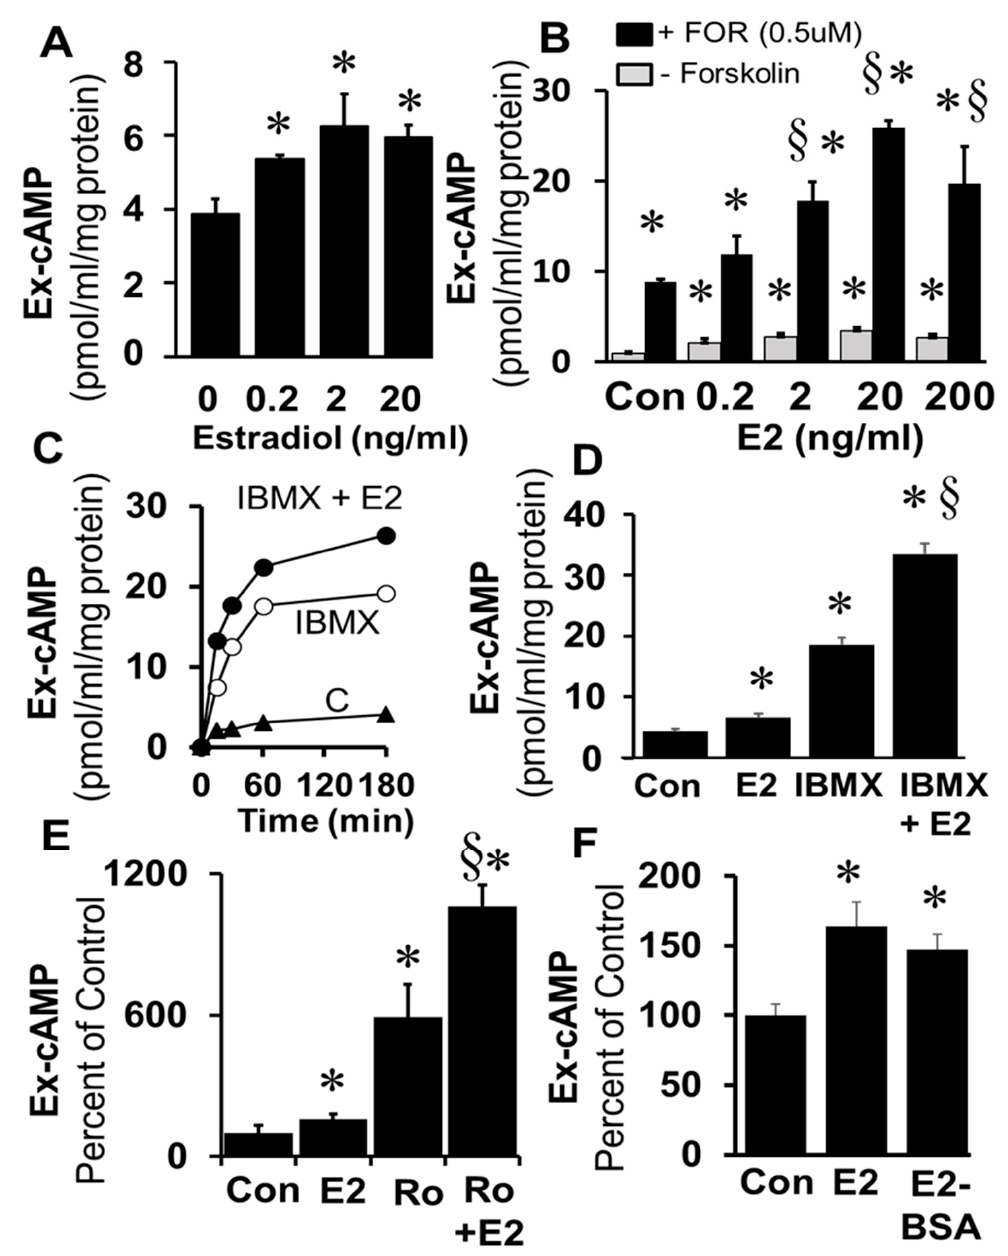
Figure 3. Panel ( A ) shows the concentration-dependent effects of 17 β -estradiol (E2; 0.2, 2, 20 ng/mL) on extracellular (Ex) cAMP levels in freshly prepared FT cells treated for 15 min. Panel ( B ) depicts the stimulatory effects of E2 (0.2, 2, 20, 200 ng/mL) in confluent monolayers of FT cells in the presence of the adenylyl cyclase stimulator forskolin (0.5 µ M). Panel ( C ) shows the time-dependent increases in cAMP levels in FT cells treated for 0–180 min with IBMX (1 µ M) or IBMX (1 µ M) plus E2 (20 ng/mL) compared with untreated control ( C ) cells. Panel ( D ) depicts the stimulatory effects of E2 (20 ng/mL) on cAMP levels in FT cells in presence of IBMX (1 µ M) after 180 min. Panel ( E ) shows the stimulatory effects of E2 (20 ng/mL) on cAMP levels in FT cells in presence of Ro20-1724 (1 µ M) after 180 min. Panel ( F ) shows the stimulatory effects of E2 and its membrane impermeable analog (E2-BSA) on cAMP levels in cultured FT cells treated for 15 min. Data (mean ± SEM) represent the mean of three different experiments ( n = 3) in triplicate. Values were normalized to total protein concentration and the cAMP level is expressed as pmol/mL/mg protein or as percent of control (* p < 0.05 vs. control; § p < 0.05 vs. Ro or IBMX or Forskolin alone).